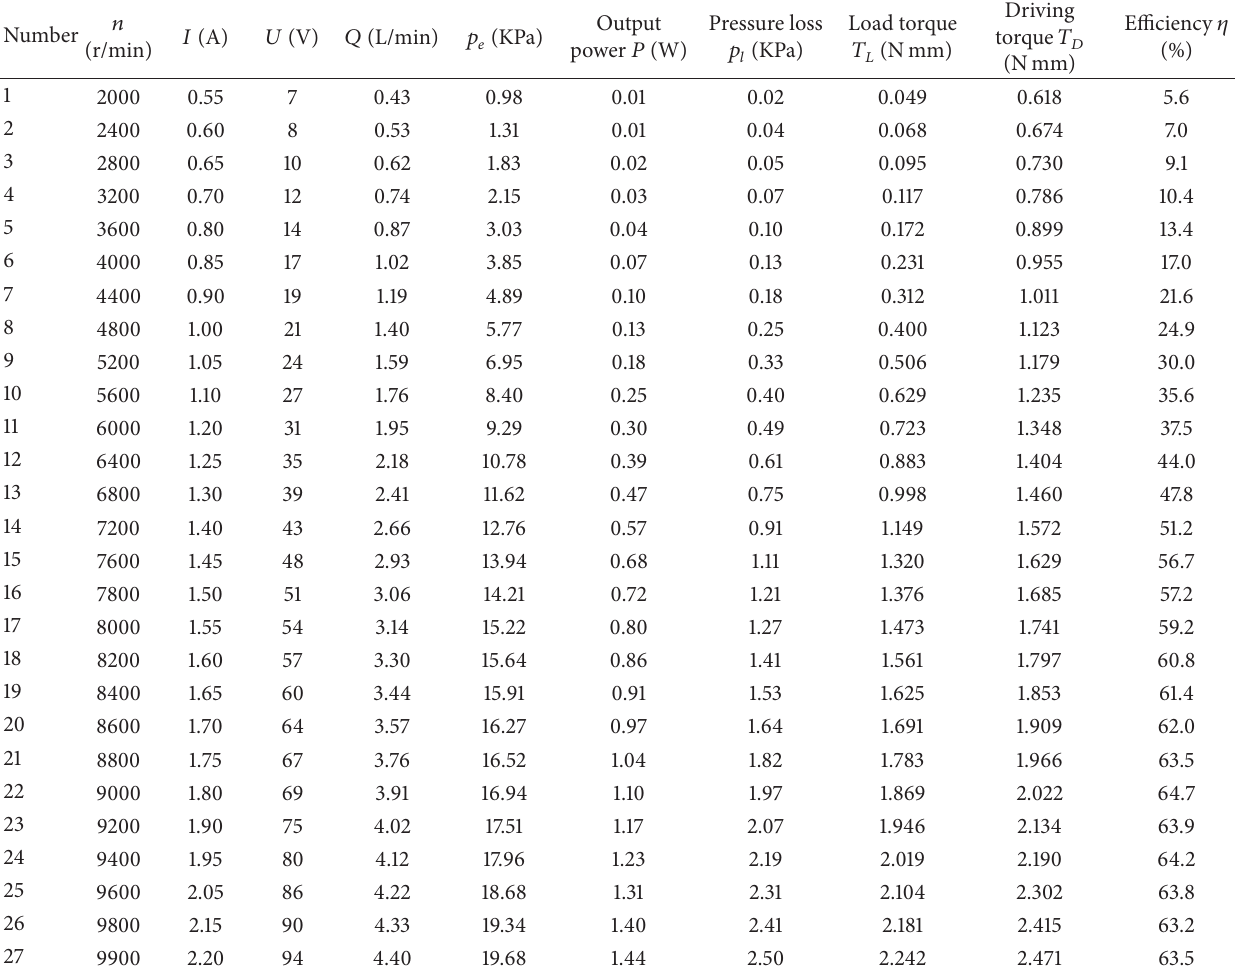
Table 3: Driving performance of the system under the condition of different